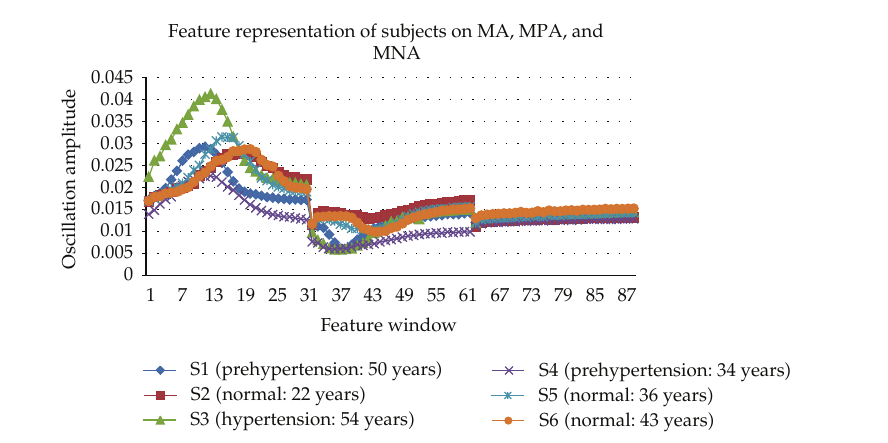
Figure 6: Features extracted with mean amplitude and maximum positive and negative amplitudes in the feature windows from normal and hypertension (cid:3) prehypertension (cid:4)